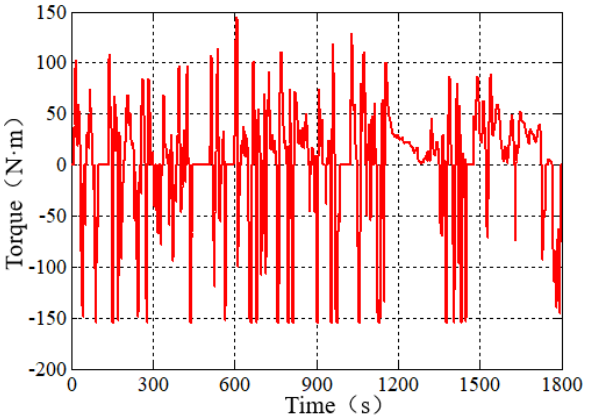
Figure 17. Motor torque in the NEDC condition.